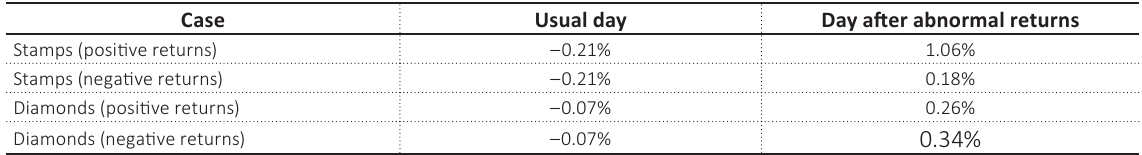
Table A1. Average analysis of returns on usual days and days after abnormal returns: The case of